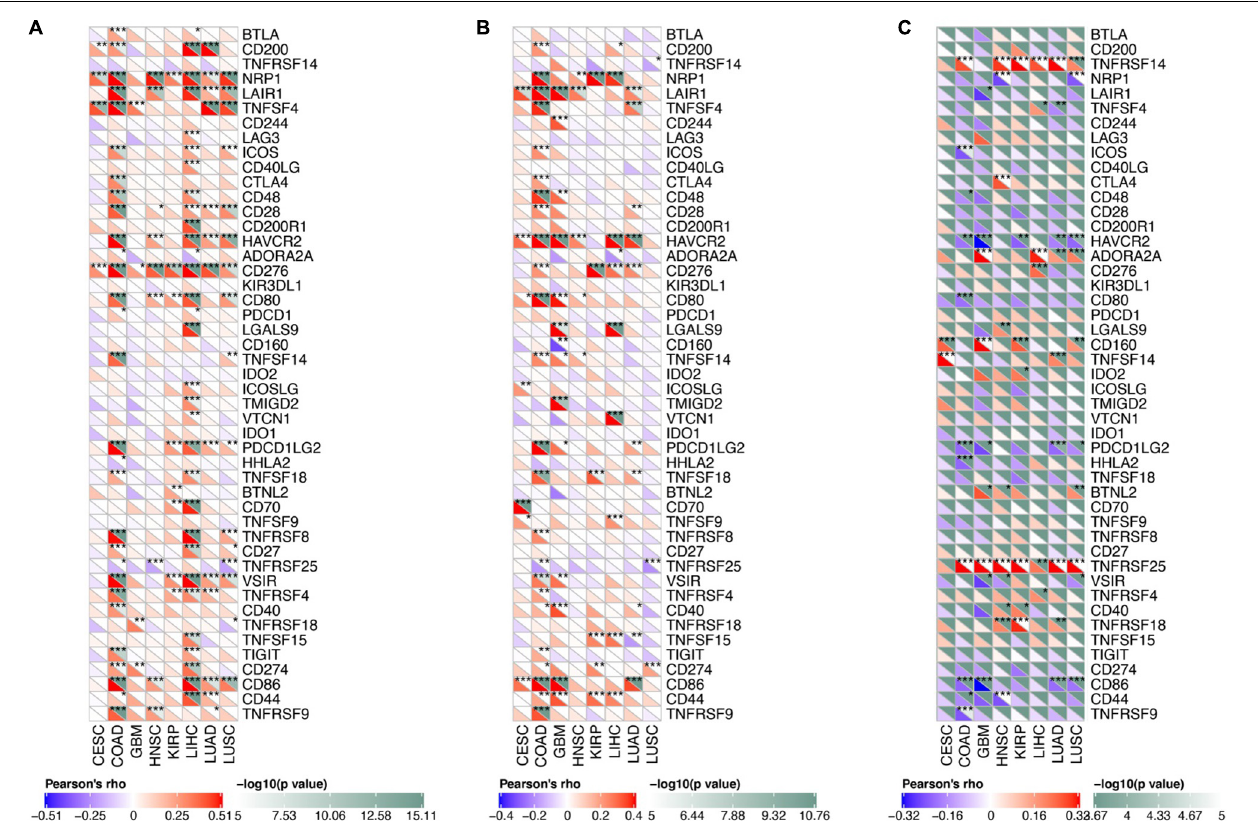
FIGURE 9 | Correlation between osteomimetic markers (A) SPARC, (B) SPP1 and (C) BGLAP and immune checkpoints in the cancer types in which osteomimicry indicated unfavorable survival. SPARC (A) and SPP1 (B) expression were positively correlated to DC-related markers CD86, NRP1 and inhibitory checkpoint markers including LAIR1, HAVCR2 and PDCDLG2 in most cancer types. SPARC (A) expression was positively and significantly correlated to CD276 (B7-H3) in all the eight cancer types. BGLAP (C) expression was positively and significantly correlated to TNFRSF25 in all these cancer types except CESC. *indicated p < 0.05. **indicated p < 0.01. ***indicated p < 0.001. p < 0.05 represents that difference is statistically